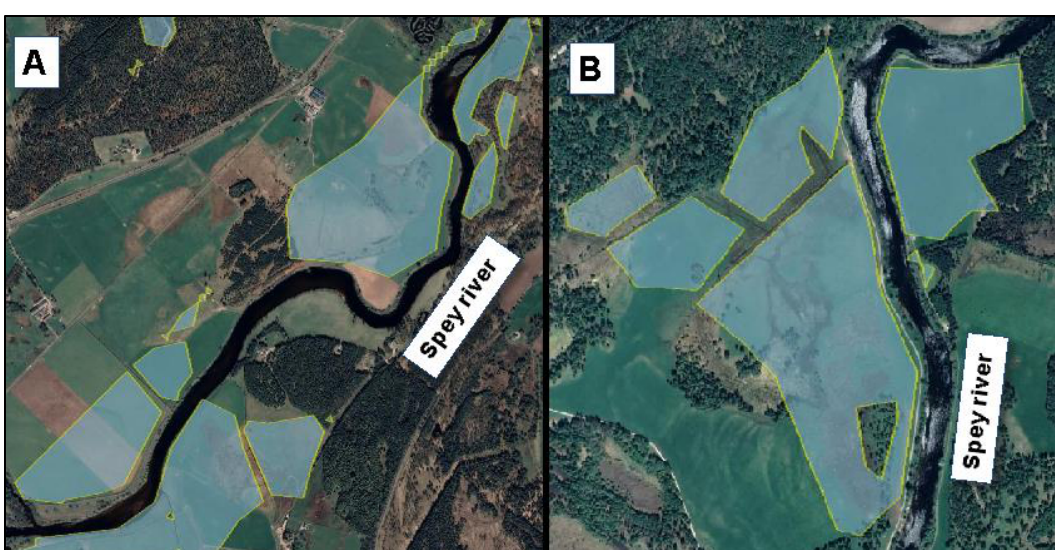
Figure 3. Accuracy of the proposed areas (blue polygons) for floodplain woodland establishment ( A , B ) .